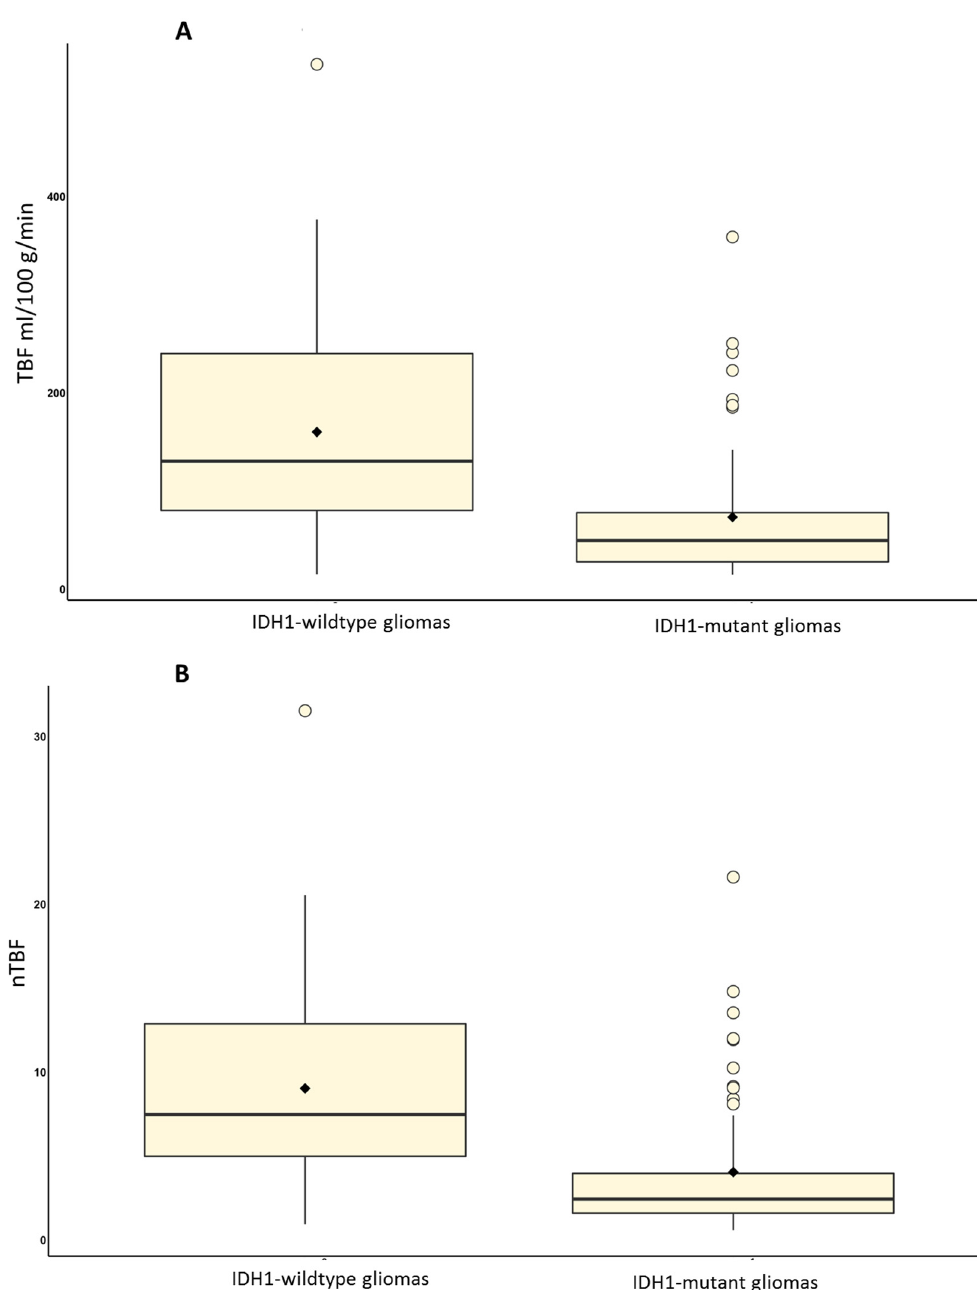
Figure 4. Boxplots of maximum ( A ) and maximum normalized ( B ) TBF in IDH1-wildtype and IDH1-mutant gliomas.